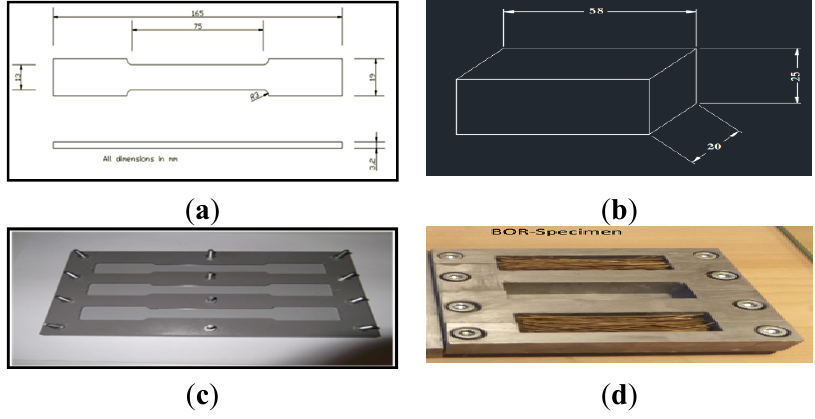
Figure 1. ( a ) Tensile specimen dimensions; ( b ) Used tensile test mold; ( c ) Tribological specimen geometry; ( d ) Tribological mold and fiber position .